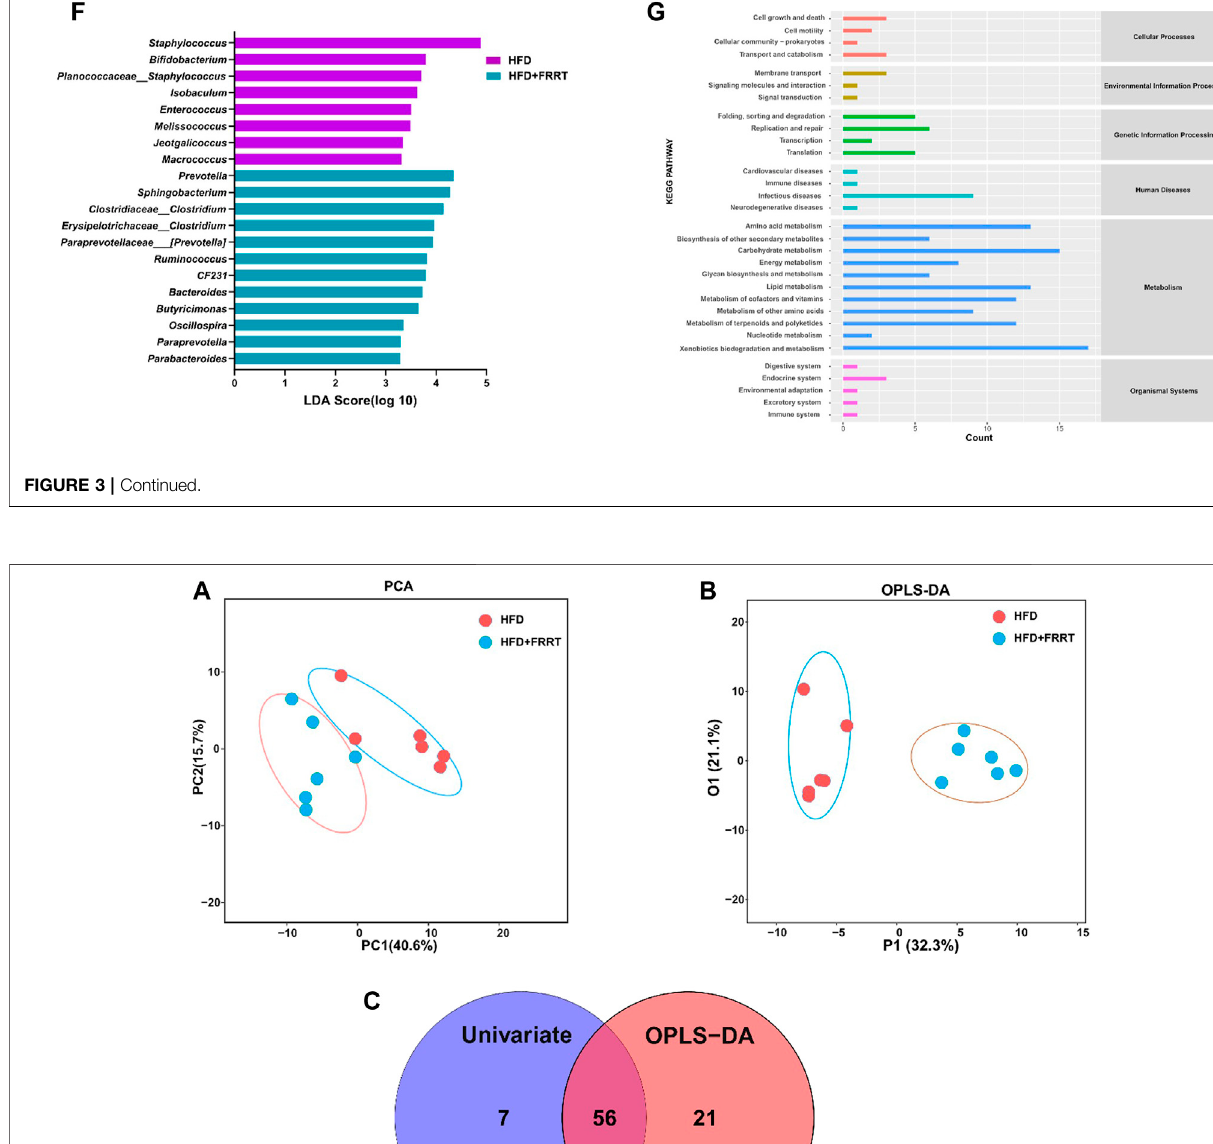
Frontiers in Pharmacology |